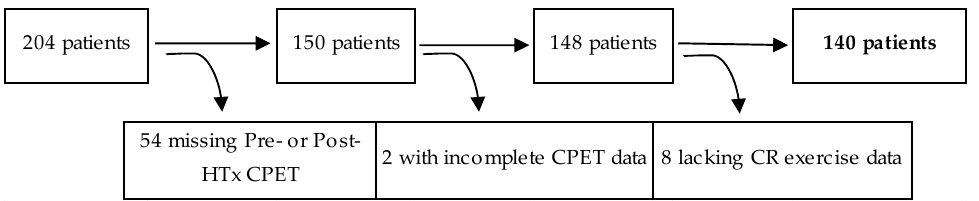
Figure 1. Flowchart for patient inclusion and exclusion. Of the initially identified 204 HTx patients, 54 patients lacked a pre-HTx or post-HTx CPET, 2 patients had incomplete CPET data, and 8 patients were lacking CR exercise session data, resulting in 140 patients for study analysis. HTx, cardiac transplantation; CPET, cardiopulmonary exercise testing.